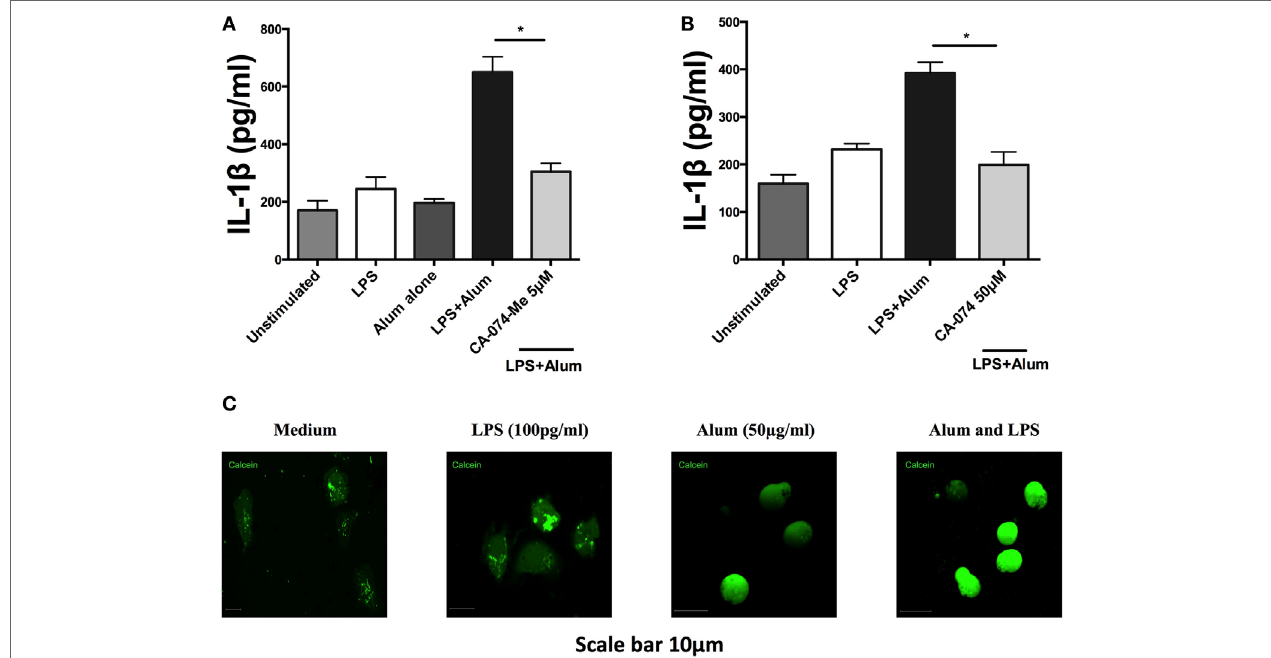
FigUre 7 | Alum induces lysosomal disruption and inhibition of lysosomal cathepsin B reduces alum-induced IL-1 β secretion in bovine peripheral blood mononuclear cells (PBMCs). Bovine PBMCs from three animals were seeded and stimulated with LPS (100 pg/ml). Cells were then incubated with CA-074Me (a) or CA-074 (B) prior to stimulation with alum (50 µg/ml). Supernatants were collected after 24 h and IL-1 β concentrations were detected by ELISA. (c) PBMCs treated with medium, LPS or alum were incubated with calcein for 3hr and visualized by confocal microscopy. For ELISA analysis, results are mean cytokine concentrations ( + SEM) in supernatants that were tested individually in triplicate. * p < 0.05, ** p < 0.01, *** p < 0.001 were calculated using GraphPad. FigUre 8 | Proposed mechanism of alum-induced IL-1 β secretion from bovine peripheral blood mononuclear cells (PBMCs). Alum enters the cell and induces lysosomal degradation to release cathepsins. From murine studies, it is proposed that cathepsin B can drive NLRP3 activation, which then mediates ASC oligomerization and caspase-1 and/or caspase-8 activation. These responses lead to the secretion of processed IL-1 β from bovine PBMCs.